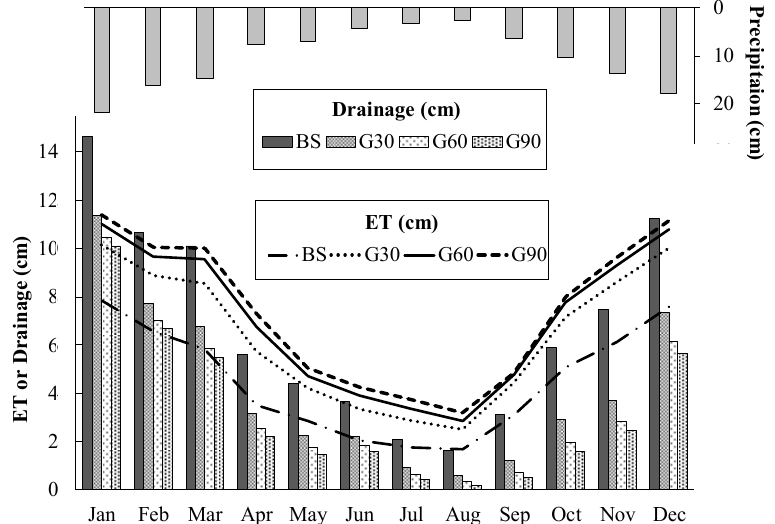
Figure 8. Monthly average of drainage and evapotranspiration using real climatic data for eight soils under BS (bare soil), G30, G60, and G90 (Grass with 30, 60 and 90 cm rooting depth) scenarios.